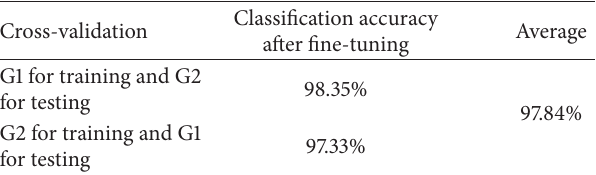
Table 5: Identification results on two fault